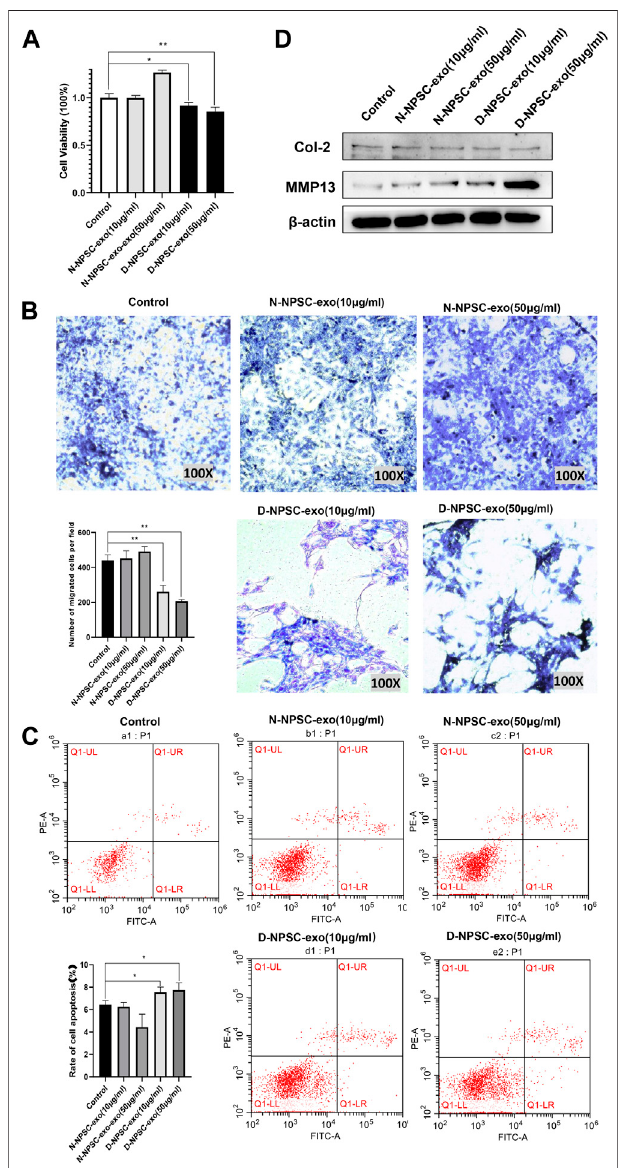
FIGURE 2 | Degenerative intervertebral disc-derived nucleus pulposus stem cells secreted exosomes (D-NPSC-exo) inhibited proliferation, migration, and extracellular matrix synthesis, and promoted apoptosis of AFCs. (A) Proliferation of AFCs treated with D-NPSC-exo, normal intervertebral disc-derived nucleus pulposusstemcellssecretedexosomes(N-NPSC-exo),orPBS(controlgroup)was evaluated by cell counting kit 8 (CCK-8) assay. D-NPSC-exo in both low (10 μ g/ml) and high (50 μ g/ml) concentrations signi fi cantly inhibited cell proliferation, and N-NPSC-exoinhigh(50 μ g/ml)concentrationspromotedcellproliferation,oppositely. (B) Migration of AFCs was evaluated by Transwell assay. D-NPSC-exo in both low (10 μ g/ml)andhigh(50 μ g/ml)concentrationssigni fi cantlyinhibitedcellmigration,and N-NPSC-exo promoted cell migration, oppositely. (C) Apoptosis of AFCs was evaluated by Annexin V/PI apoptosis detection kit. D-NPSC-exo in both low (10 μ g/ ml) and high (50 μ g/ml) concentrations signi fi cantly promoted cell apoptosis. However,N-NPSC-exoinhigh(50 μ g/ml)concentrationsreducedtheapoptoticrate of AFCs. (D) Protein expression levels of Col II, and MMP13 were detected by Western blotting. D-NPSC-exo in high (50 μ g/ml) concentrations signi fi cantly promoted the expression of MMP13 and inhibits the expression of Col II. * p < 0.05; ** p <